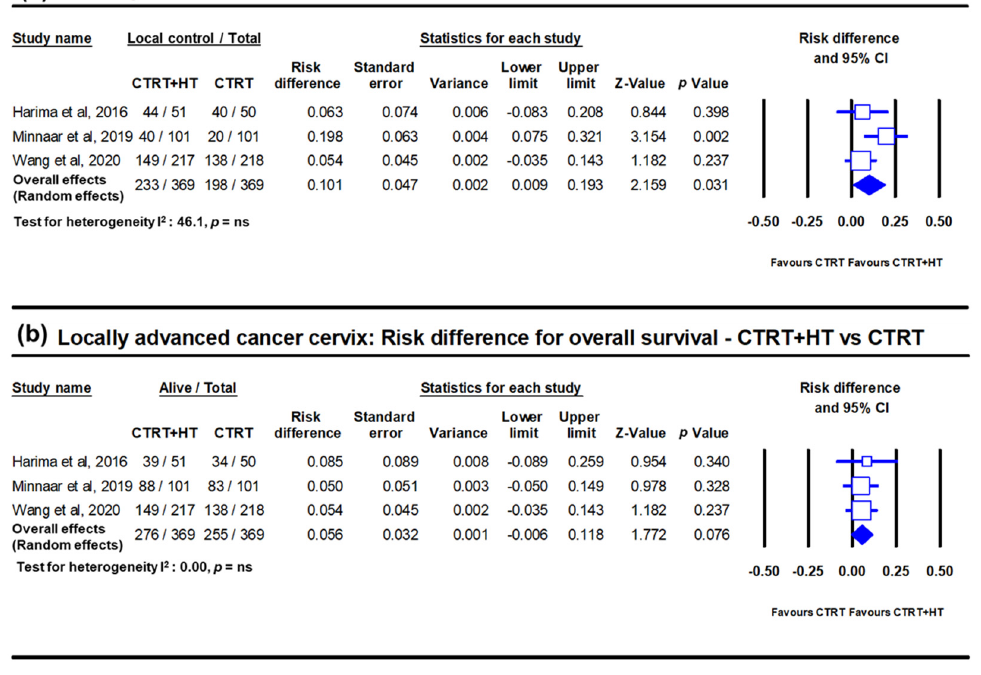
Figure 3. Forest plots depicting the risk difference in locally advanced cancer cervix for ( a ) local dis- ease control and ( b ) overall survival with chemoradiotherapy (CTRT) with hyperthermia (HT) versus CTRT alone. Data from Minnaar et al. [23] has been added to the meta-analysis from Yea et al. [22] and replotted. The risk difference for local failure with HT added to CTRT reduces by 10.1% ( p = 0.03) while the overall survival improves by 5.6% ( p = 0.07). (ns: not significant). For citations of the studies listed, please refer to